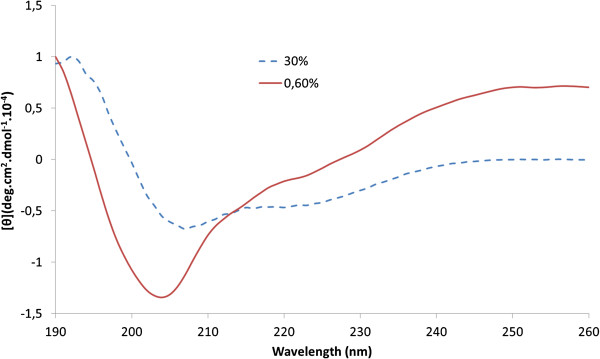
CD spectrum of Prt peptide. CD spectrum of Prt peptide in 0.6 (red line) and 30% (blue line) TFE. The final peptide concentration was 10.2 μM (0.6% TFE) and 15 μM (30% TFE). The temperature was 25°C. [θ], Molar elipticity.